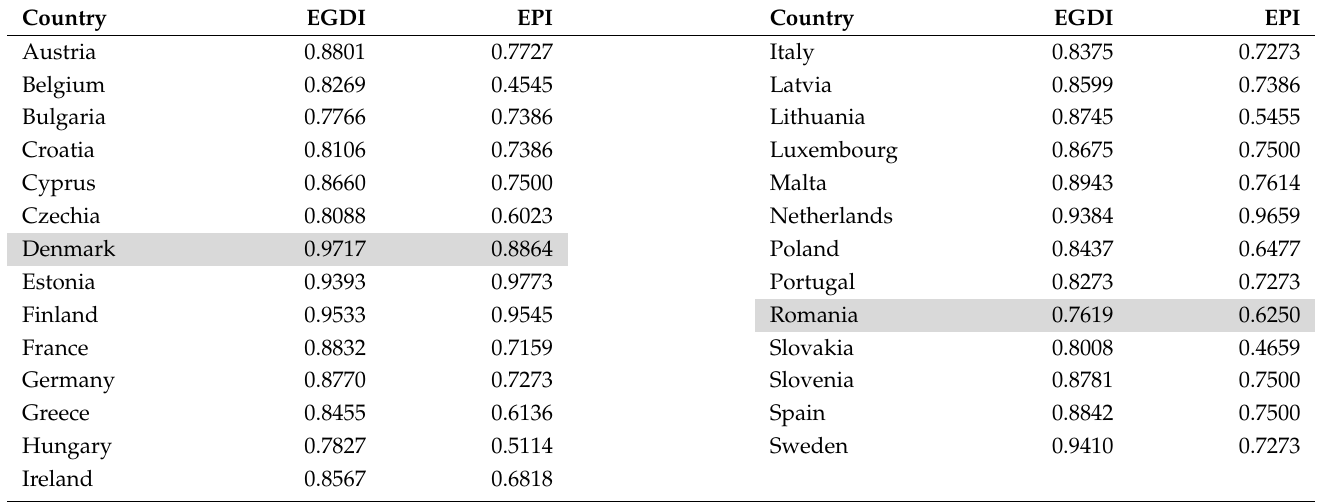
Table 2. EGDI and EPI